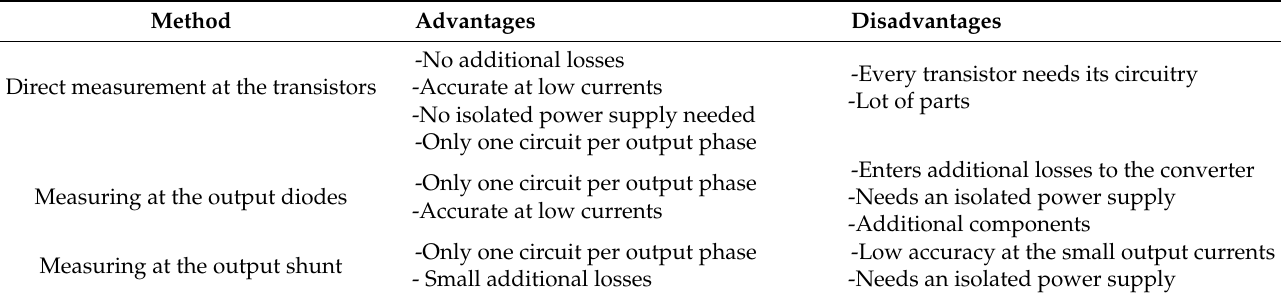
Table 1. Comparison of the basic current direction measurement methods.